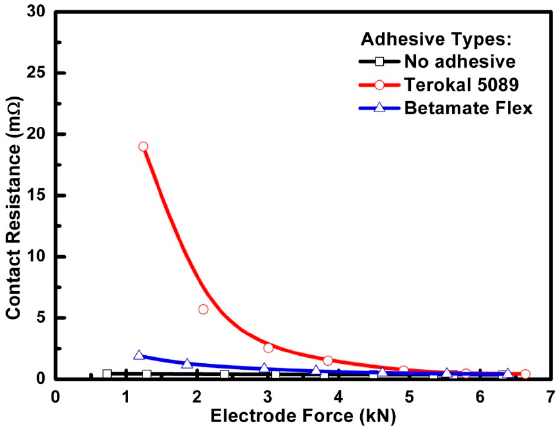
Figure 9. Effect of the adhesive types on the contact resistance between the faying interfaces.